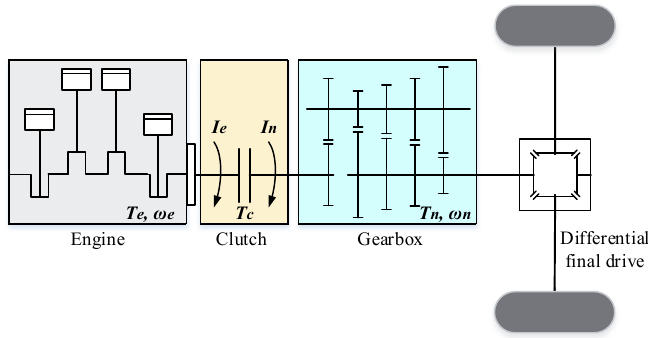
Figure 1. Simplified dynamic model of dry